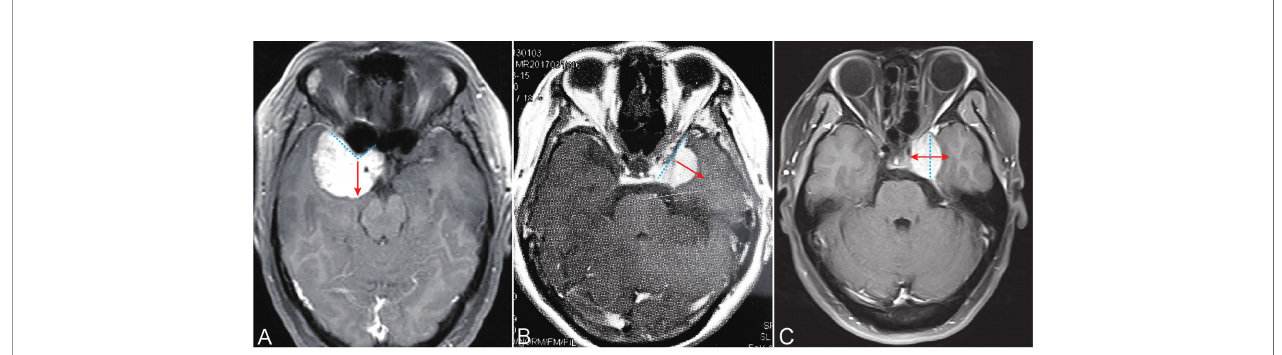
FIGURE 1 | Extension directions of three typical PCMs. (A) ACMs extended to the direction in which the anterior clinoid projected. (B) MSWMs grow perpendicular to the sphenoid ridge. (C) CSMs extended perpendicular to the lateral wall of the cavernous sinus. Cyan dash line: the base of the tumor. Red arrow: tumor